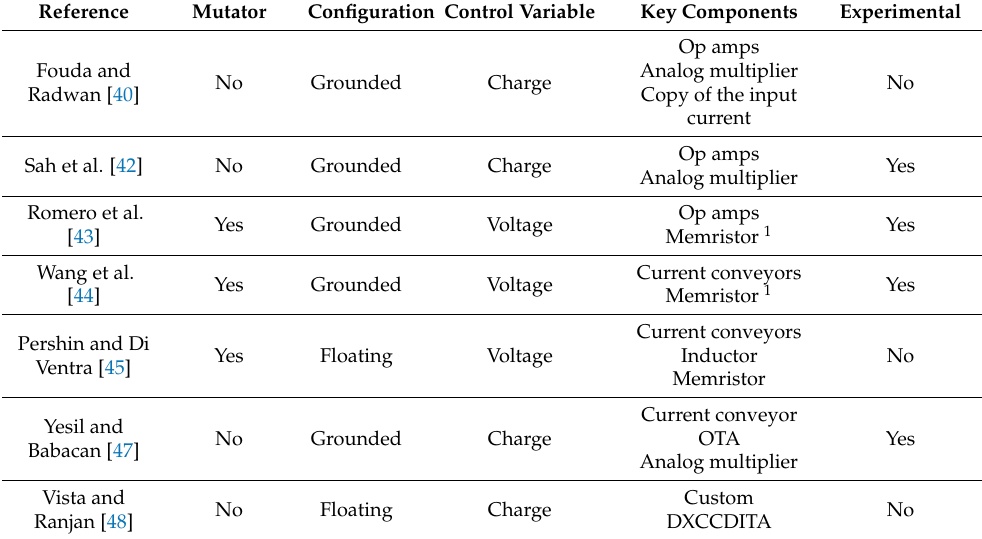
Table 1. Comparison of the different memcapacitor emulators presented in this